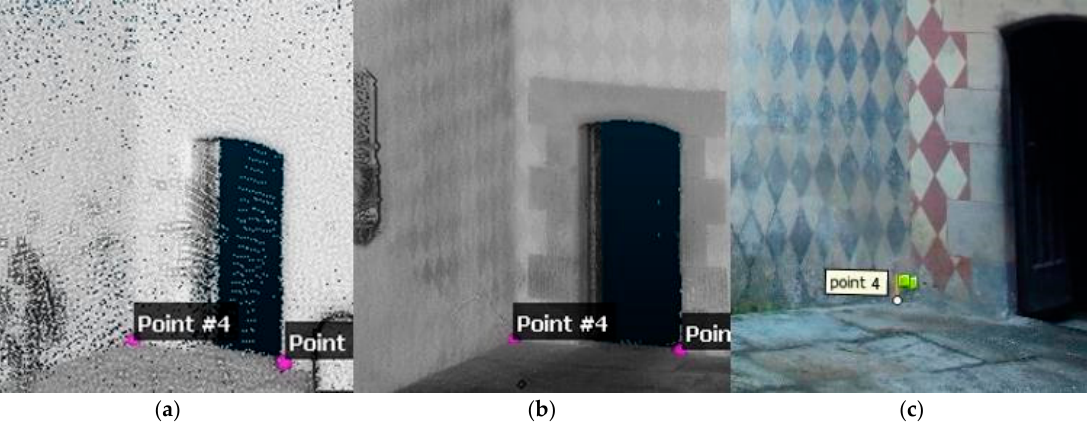
Figure 18. The n°4 points selected in ( a ) ZEB and in ( b ) TLS point cloud for coordinates’ extraction and finally the point was detected and placed on the ( c ) Digital Single Lens Reflex (DSLR) photo, for the images block-orientation.